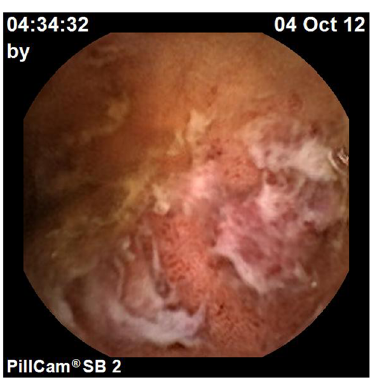
Figure 4. An occupying lesion identified by CE. An occupying lesion was identified by CE in the jejunum of a 52-year-old woman with abdominal pain for more than three months. With subsequent pathology evaluation, a diagnosis of adenocarcinoma was confirmed.